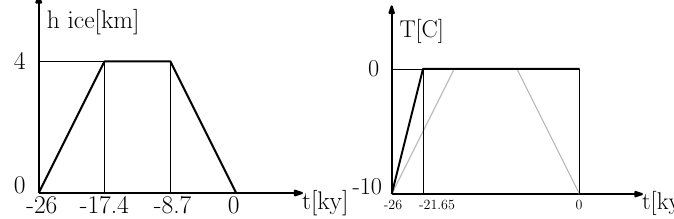
Figure 2. The evolution of the height of the ice sheet is shown on the left and the prescribed temperature field on top on the basin is reported on the